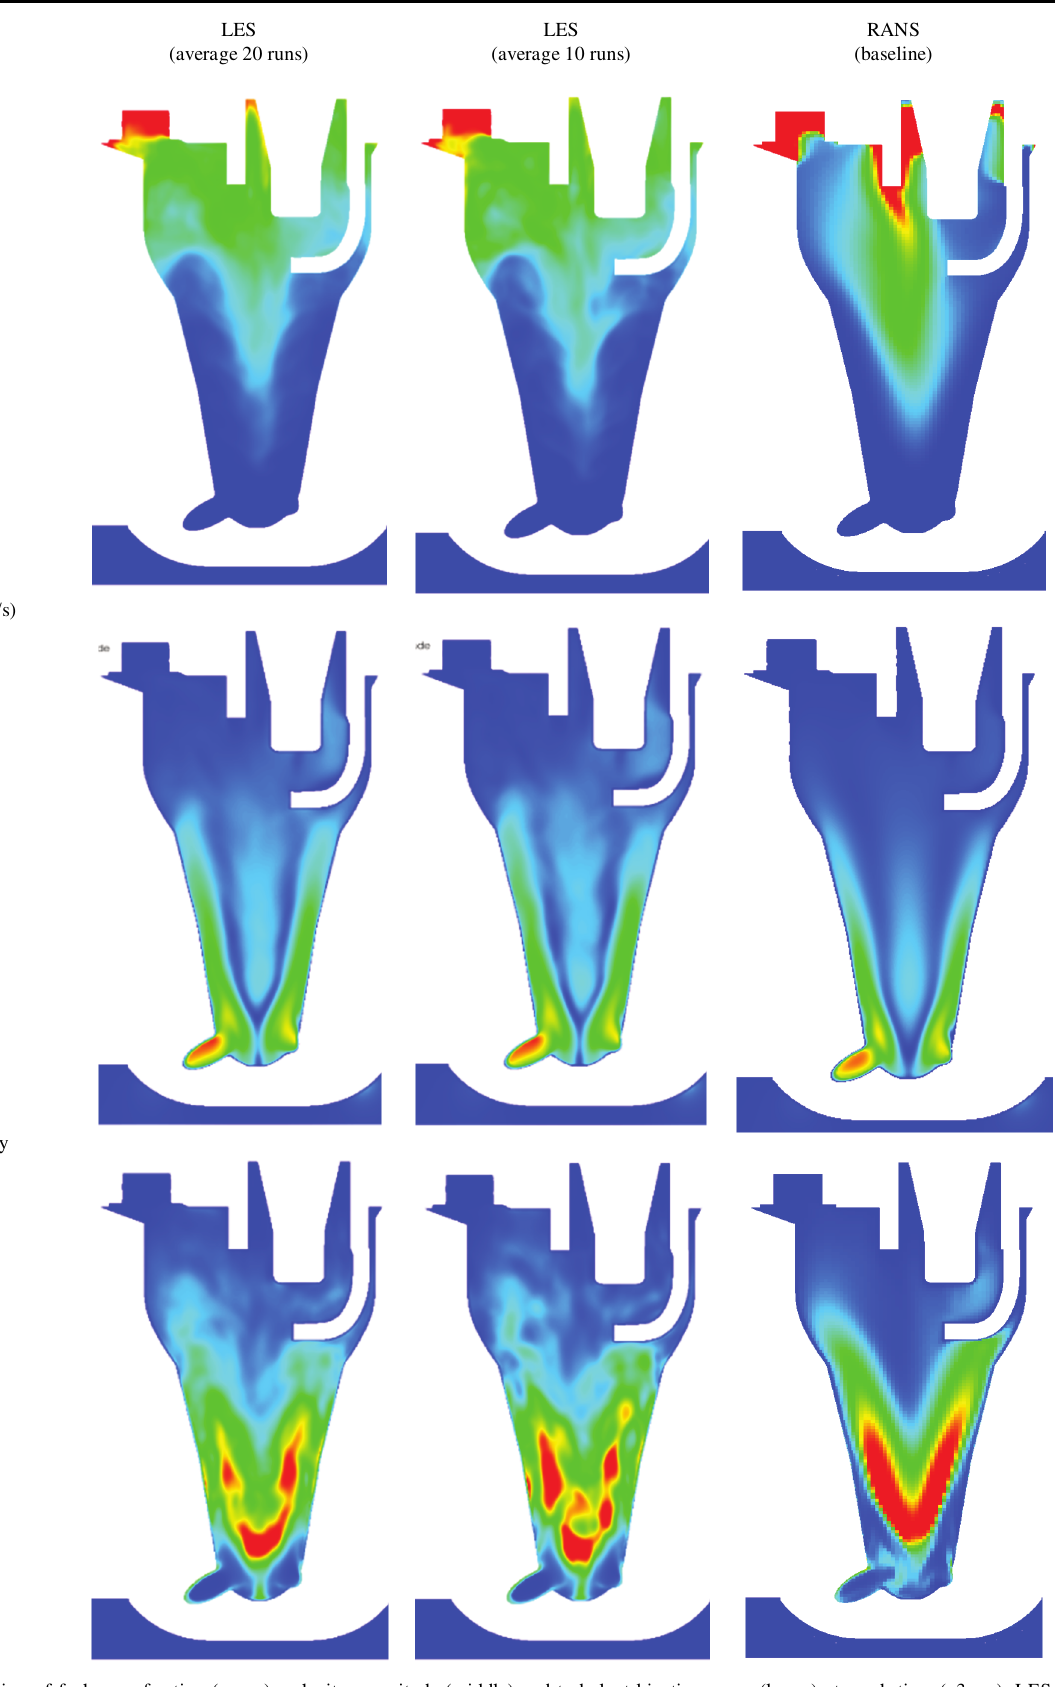
Fig. 7. Spatial distribution of fuel mass fraction (upper), velocity magnitude (middle) and turbulent kinetic energy (lower) at spark time (–3 ms). LES results have been averaged using 20 (left) and 10 (centre) runs and are compared with RANS